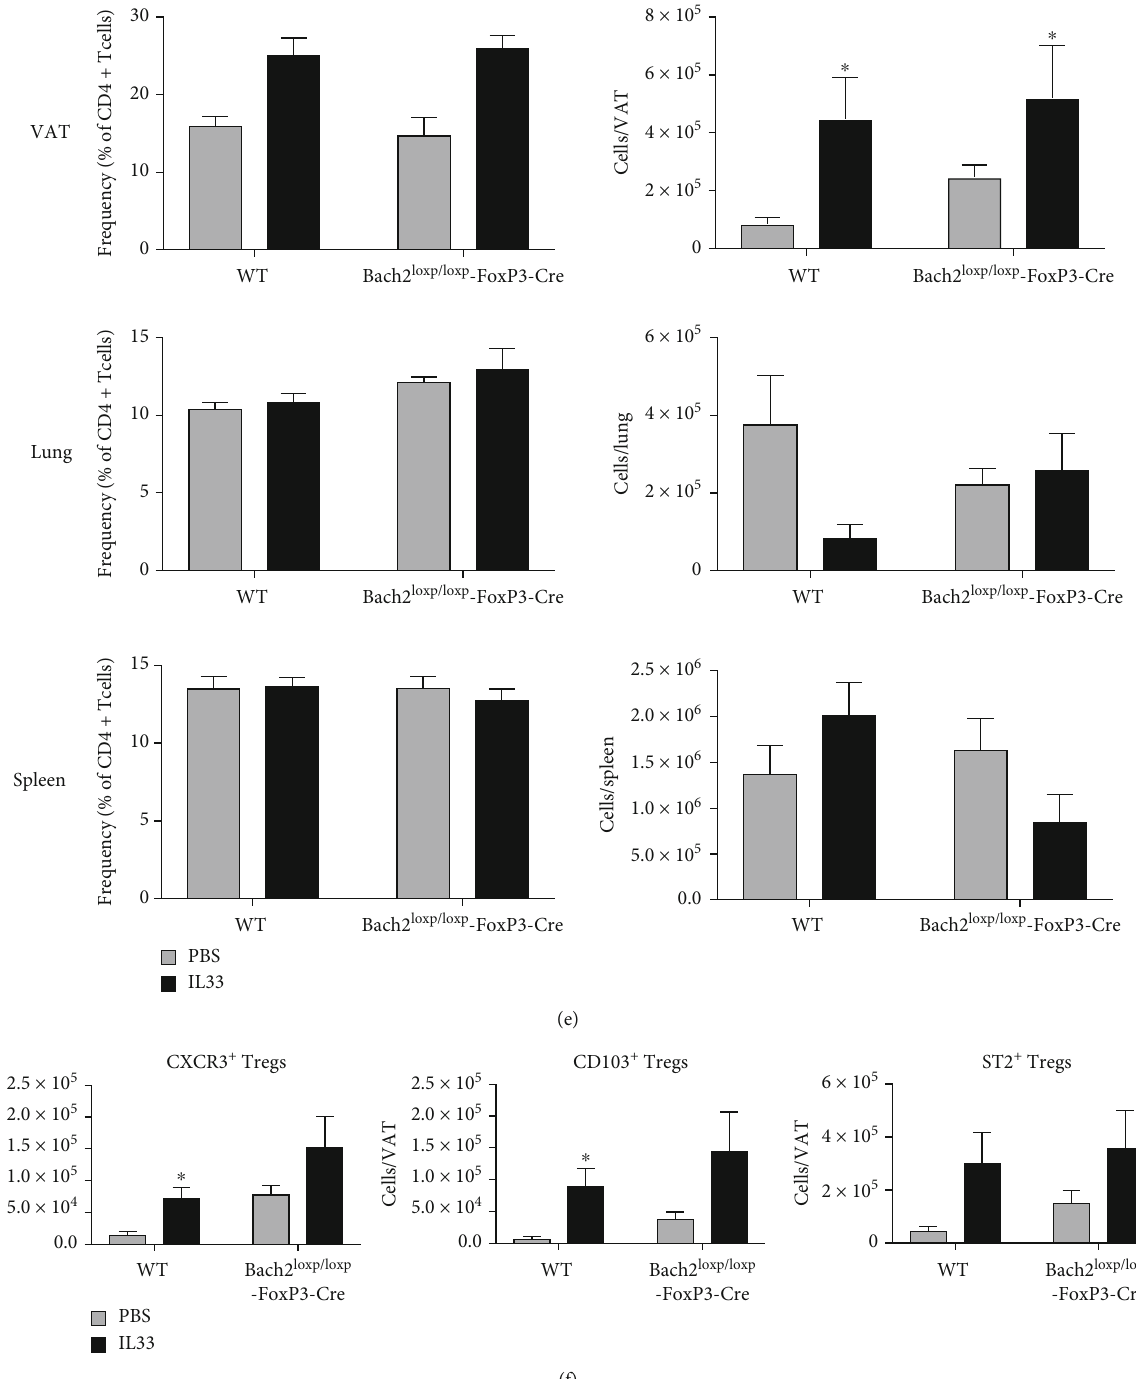
Figure 3: Bach2 limits the size of tissue regulatory T cell population in the VAT. Mononuclear cells isolated from the VAT of WT and Bach2 loxp/loxp FoxP3-Cre mice were analyzed by fl ow cytometry. Tregs in the VAT of naïve WT and Bach2 loxp/loxp FoxP3-Cre mice were analyzed for (a) their frequency and numbers, (b) tissue Treg marker expression, and (c) MFI levels for BATF, IRF4, and GATA3. (d) Splenocytes from naïve WT and Bach2 loxp/loxp FoxP3-Cre mice were stimulated in vitro with anti-CD3, anti-CD28, and IL-2 in the presence of absence of IL-33 for 72hrs. Bar graphs display frequencies of ST2 +ve and BATF +ve , IRF4 +ve , or GATA3 +ve Tregs. (E-H) WT and Bach2 loxp/loxp FoxP3-Cre mice received four injections of IL-33, and the indicated tissues were analyzed on day 8. (e) Frequency and number of Treg cells in the VAT, lungs, and spleen. (f) Number of CXCR3-, CD103-, and ST2-positive Tregs in the VAT. This experiment was repeated two times with similar results, 5 mice per group. ∗ p < 0 : 05